Question: Identify the chart type used in this figure.
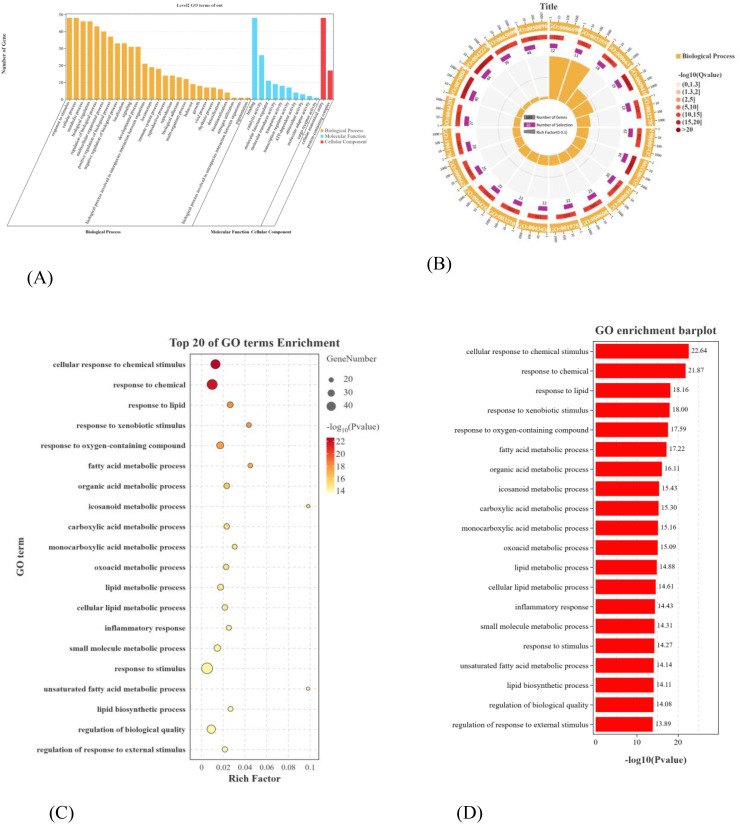
Answer: histogram